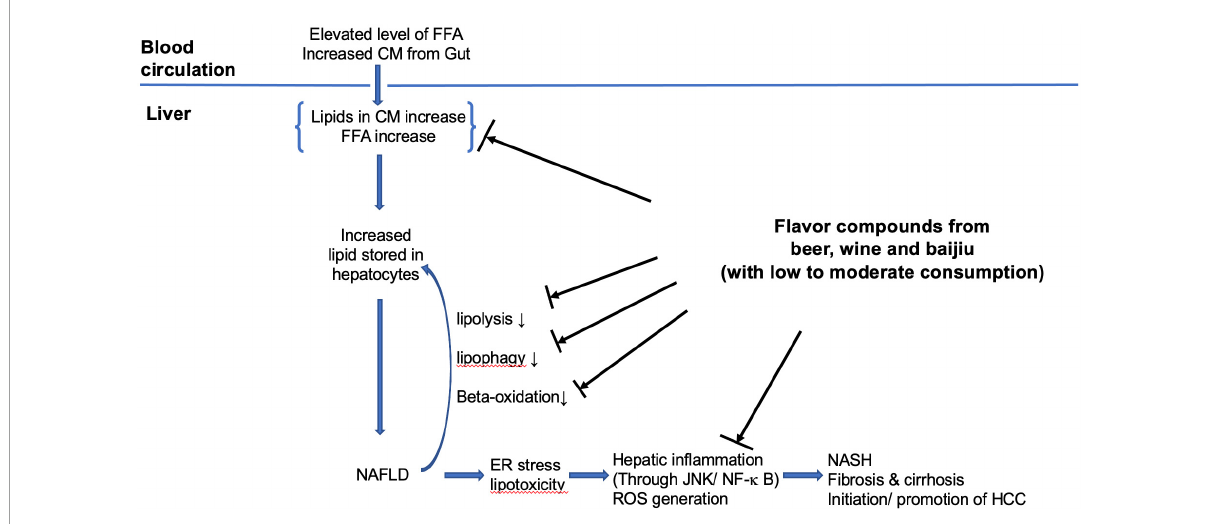
FIGURE2 The putative mechanisms of flavor compounds on NAFLD. FFA, free fatty acids; CM, chylomicron remnants; ER, endoplasmic reticulum; HCC, hepatocellular